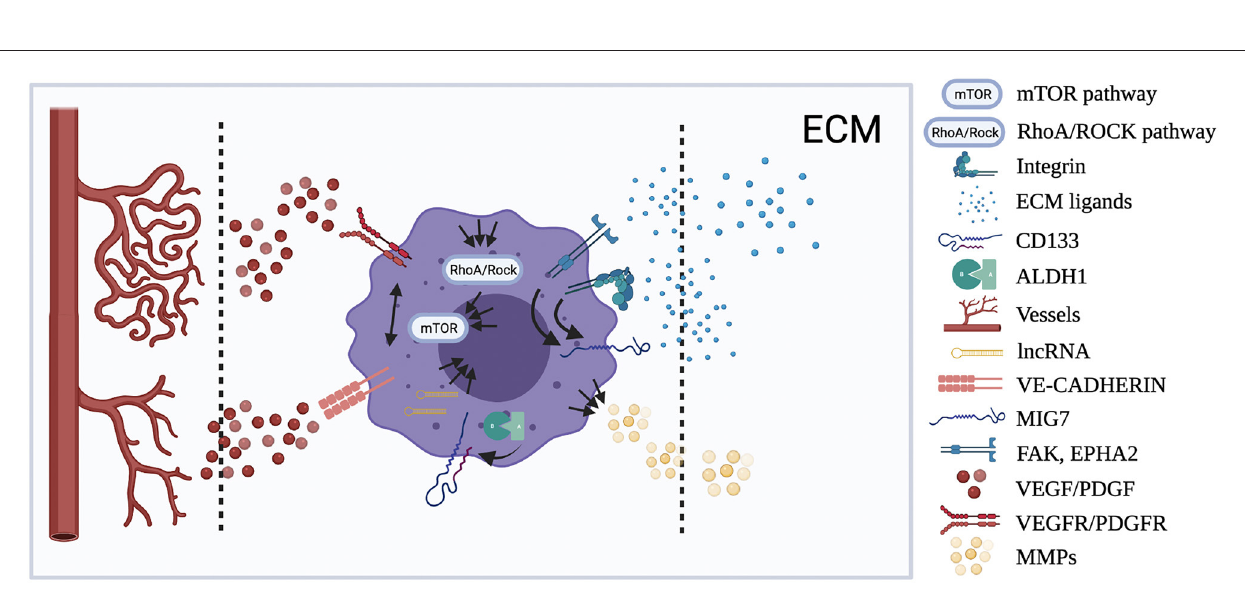
FIGURE 2 | Localization of the principal molecular pathways involved in VM. Figure shows the cellular and tumor microenvironmental distribution of the human OSA pathways resumed in the review showing, when known, the possible interactions (black arrow) between them. Multiple arrows show multiple interactions between